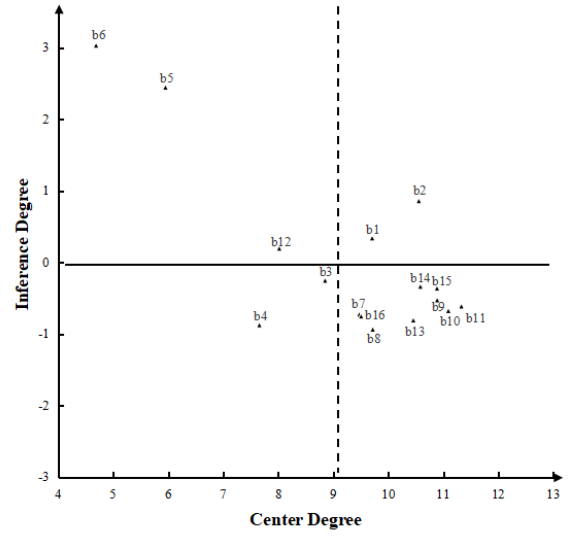
Figure 3. Centrality-causality cartesian coordinate graph.